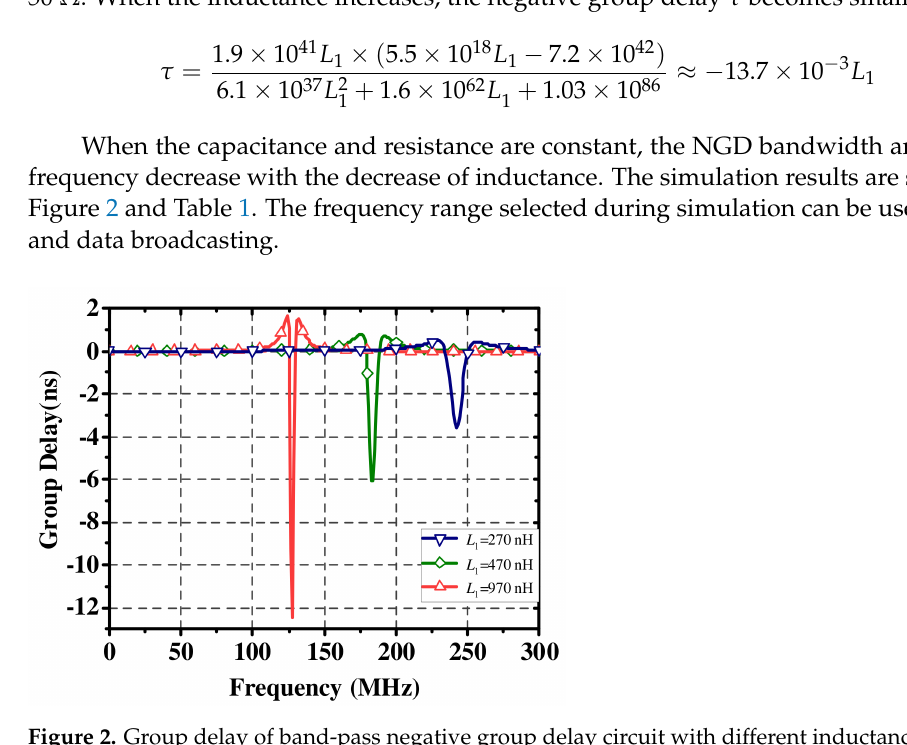
Figure 2. Group delay of band-pass negative group delay circuit with different inductance L 1 . Table 1. Data of band-pass negative group delay circuit with different